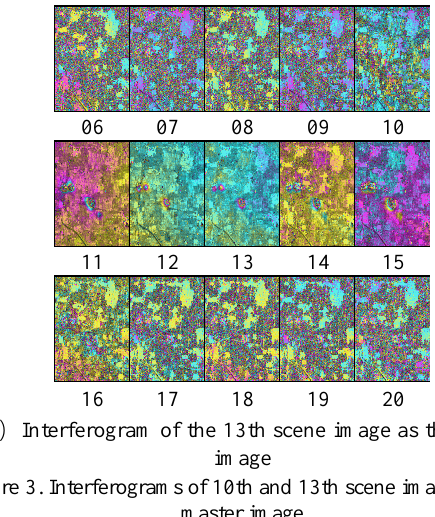
image Figure 3. Interferograms of 10th and 13th scene images as the master image